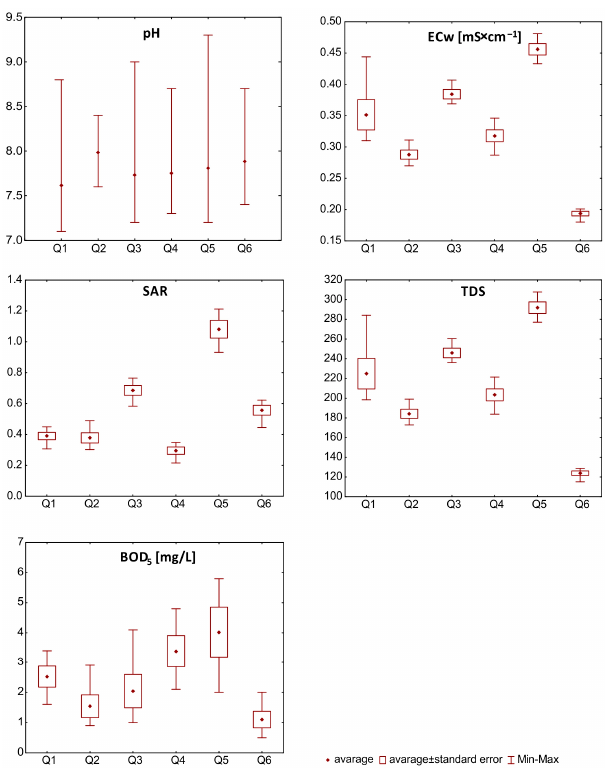
Figure 3. The average and range of variability values of the indicators that characterise the usability of water from selected quarry lakes in the Strzelin granitoids quarry lakes for agricultural irrigation (author B.J.).